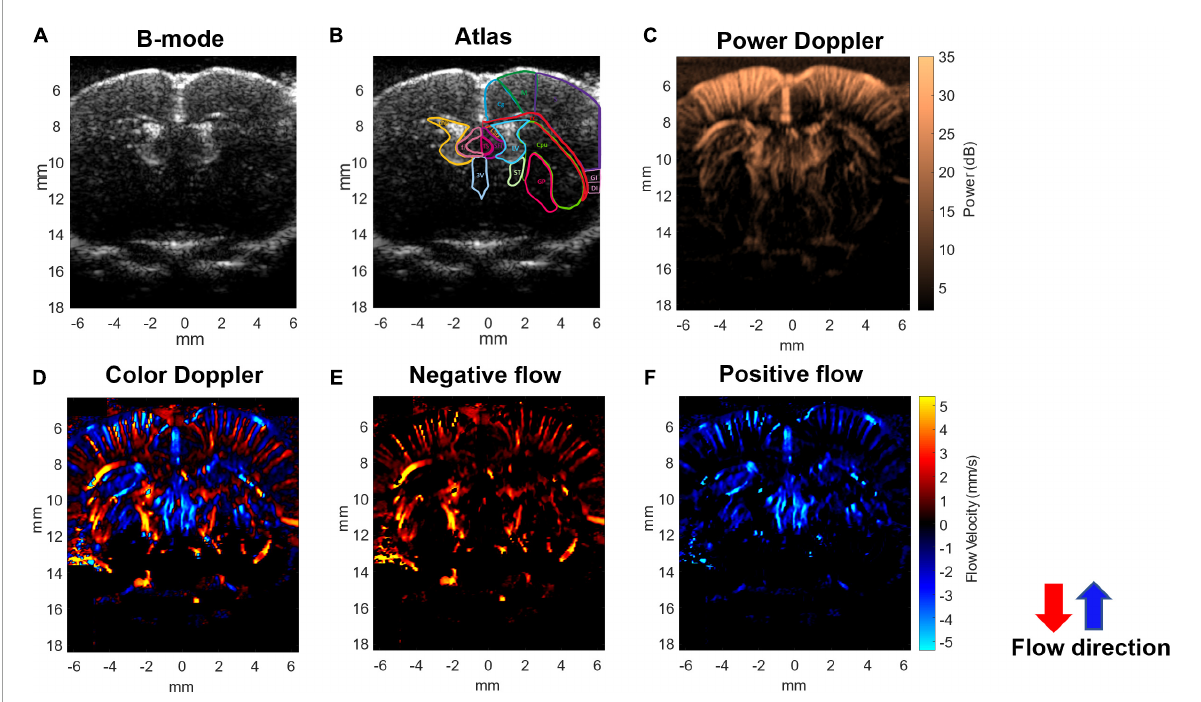
FIGURE2 Ultrafast Doppler images of the penetrating vessels in the coronal section of a representative rat brain. (A) The representative B-mode image clearly registers the lateral ventricle. (B) Corresponding coronal atlas at bregma AP –0.5 mm. (C) Ultrafast power Doppler generated from a time series of B-mode images detects the basal blood flow in cerebral cortex. (D) The color Doppler image presents flow velocity and directional blood flow toward/outward the ultrasound transducer. (E) Negative flow corresponding to blood flow away from the transducer is coded as red. (F) Positive flow corresponding to blood flow toward the transducer is coded as blue. In the cerebral cortex, blood in most penetrating arteries and arterioles flows away from the transducer and is coded as red. Blood in most penetrating veins and venules flows toward the transducer and is coded as